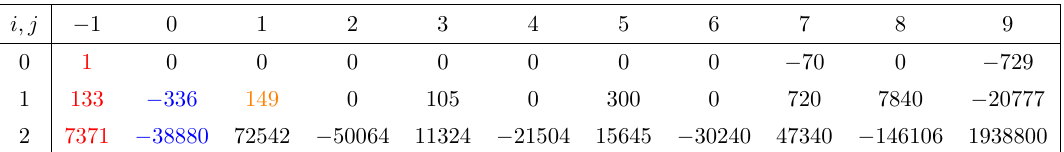
Table 17 . Series coefficients c i,j for the one-string elliptic genus of the n = 2 E 7 model.